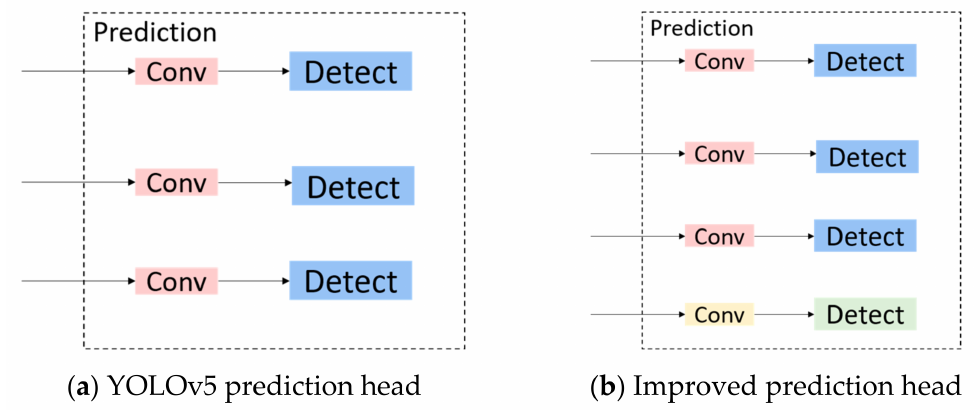
Figure 7. Comparison of YOLOv5 prediction layer and proposed